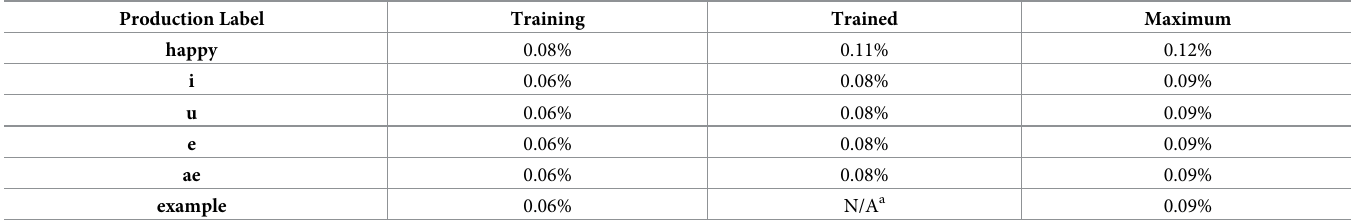
Table 1. Normalized Root-Mean-Square Error (RMSE) of TorchDIVA motor signal. Production